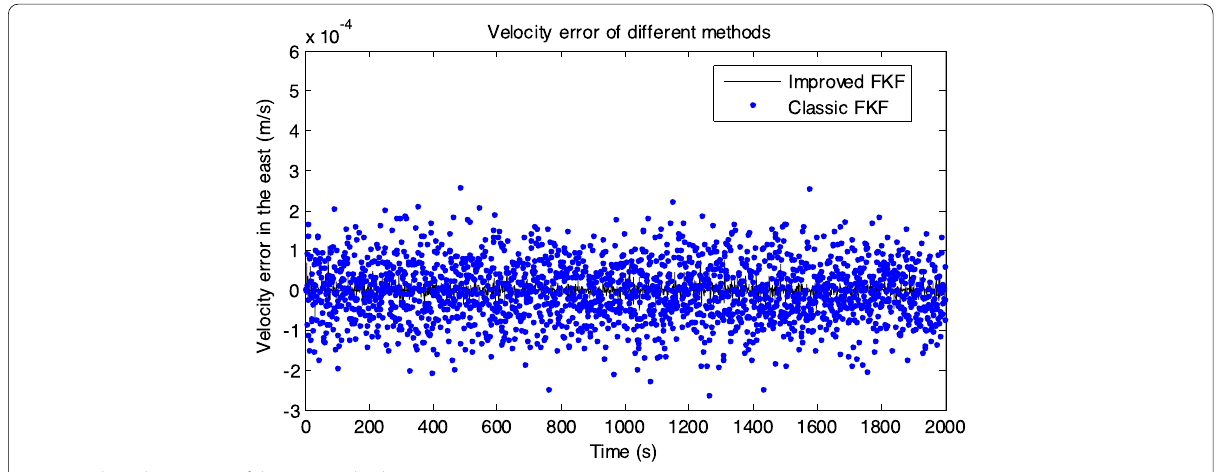
Fig. 12 The velocity error of the two methods